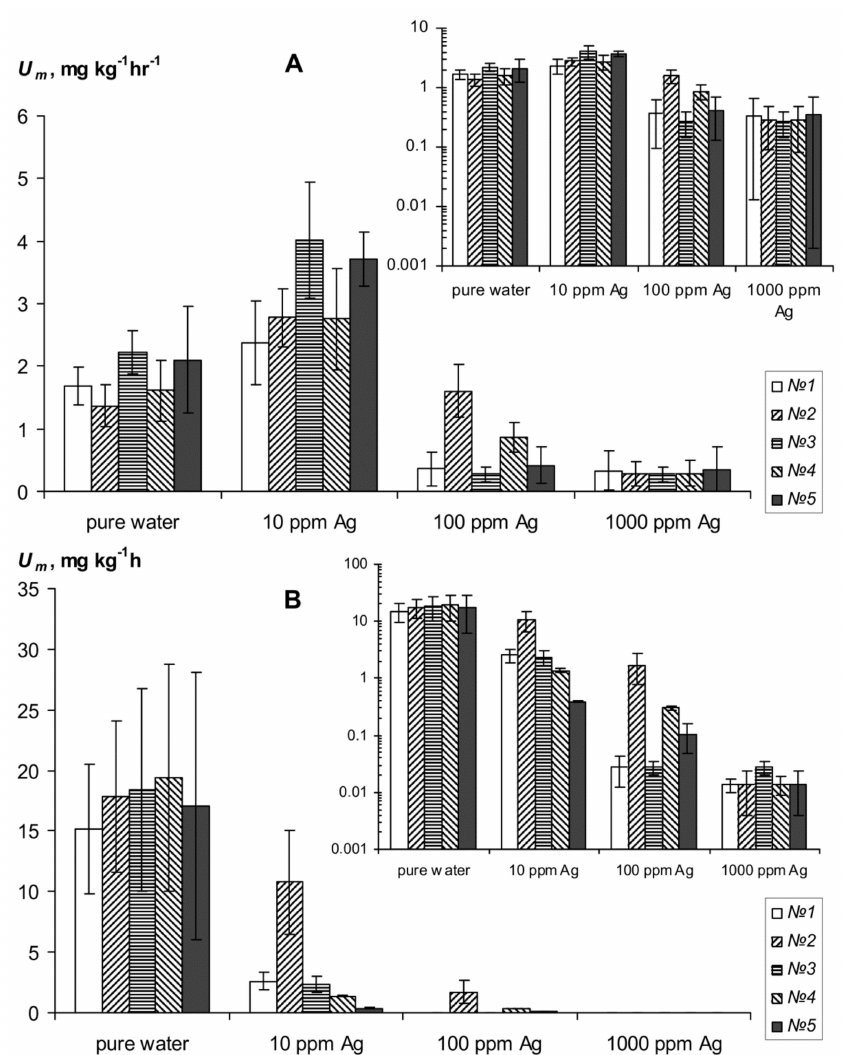
Figure 4. The change in U m of hydrogels and gel compositions with silver in the case of mixing of root rot and sandy substrate; N o N o 1–4 are different types of hydrogels (see “Objects and methods”); ( A ) is ionic silver and ( B ) colloidal silver; insets are semi-logarithmic